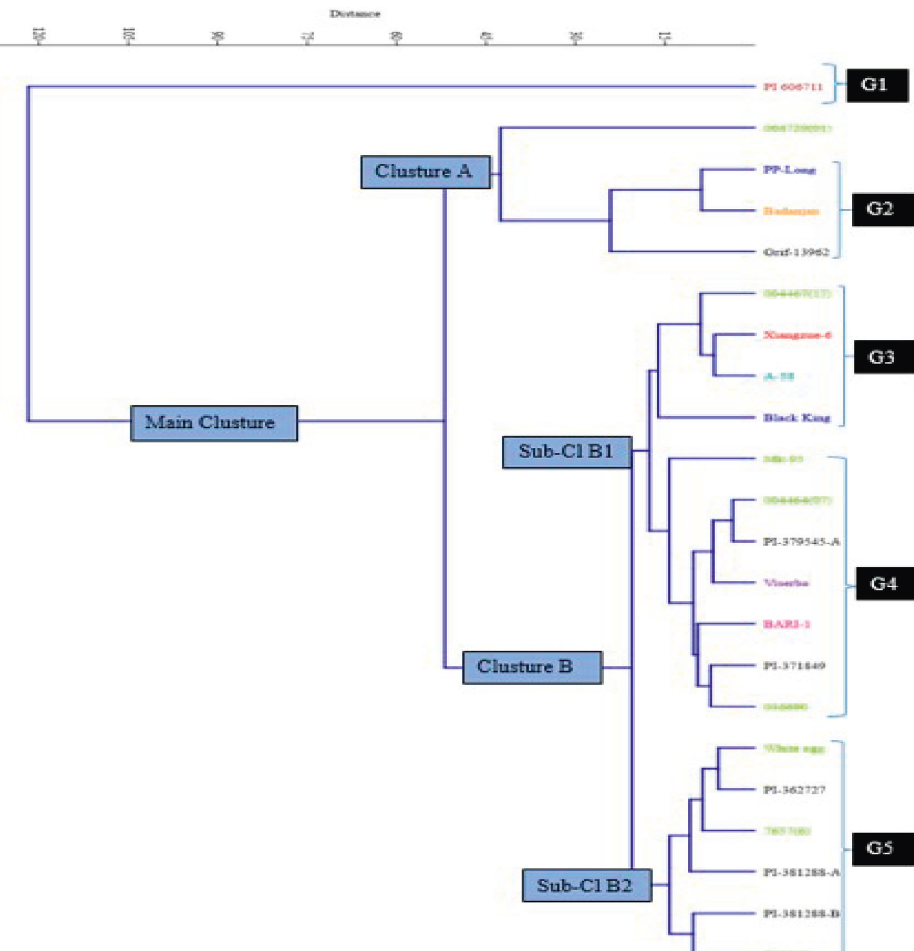
Figure 5: UPGMA dendrogram constructed from morphological data showing a genetic relationship among 22 eggplant